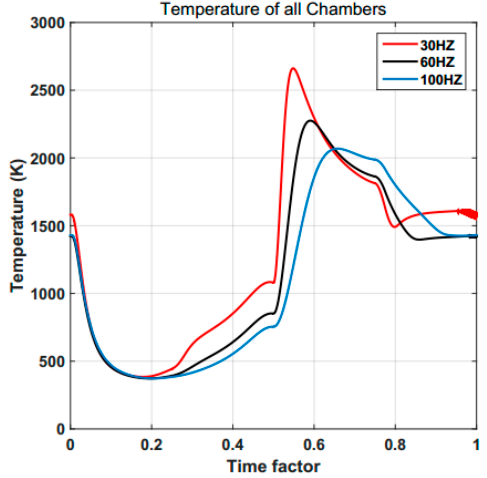
Figure 19. Changing process of temperature at different frequencies.